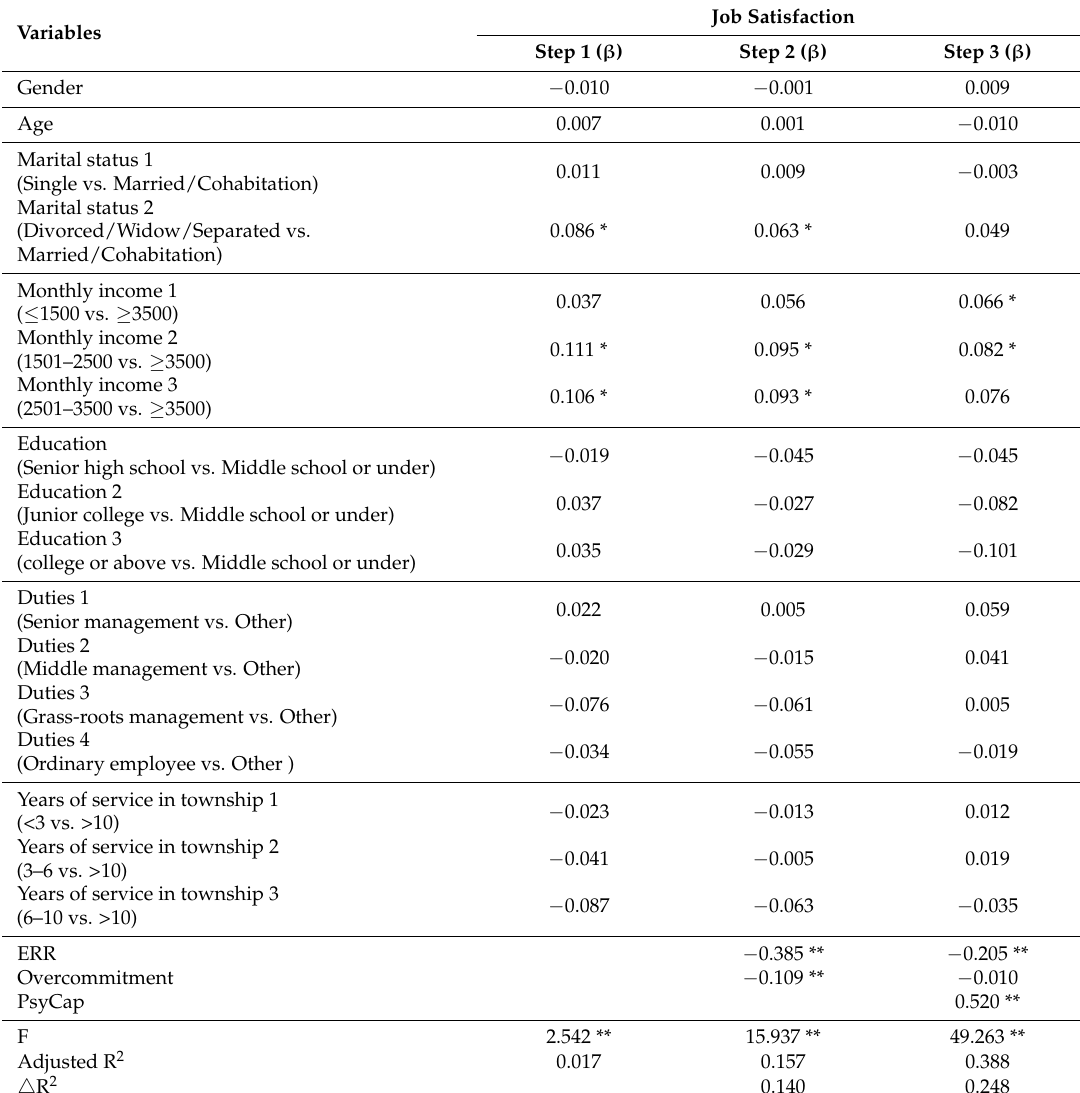
Table 3. The hierarchical linear regression analysis for job satisfaction in the total